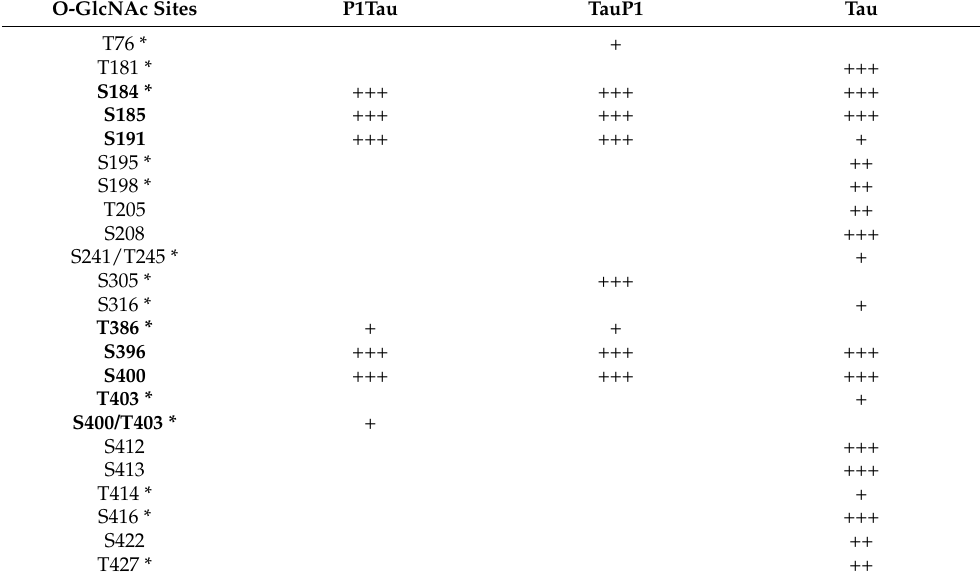
Table 1. O-GlcNAc sites of Tau and tagged